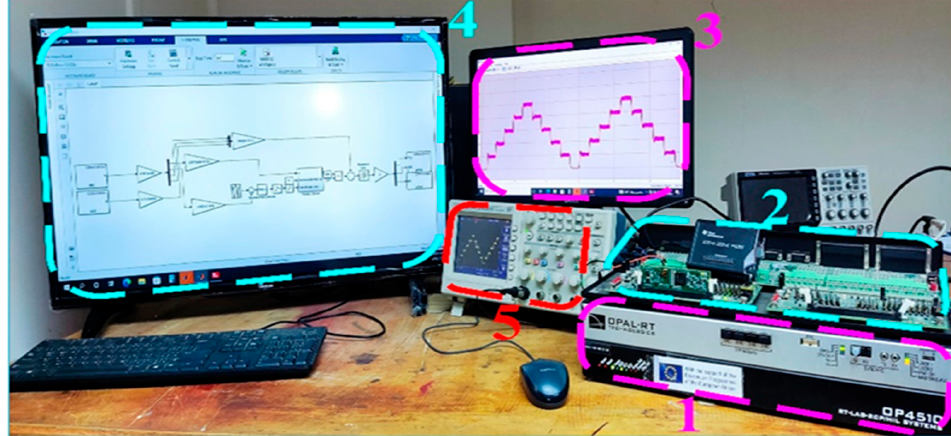
Figure 20. Control-hardware-in-the-loop platform: (1) Opal-RT real-time simulator, (2) OP8665 controller interface, (3) opal interface and monitoring, (4) DSP interface, (5) Oscilloscope.